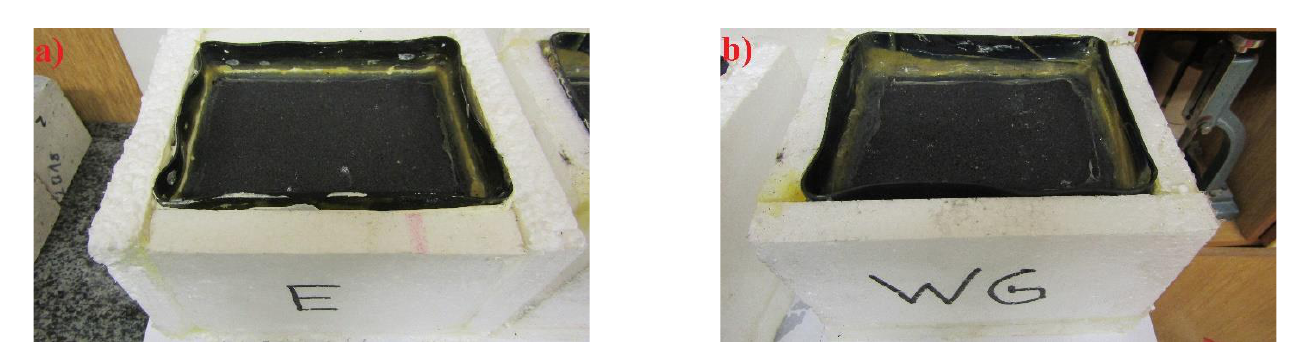
Figure 9. The appearance of the surfaces of reference concrete blocks ( a ) and concrete blocks modified with CRT glass ( b ) after 28 cycles of freeze/thaw and de-icing salt action.